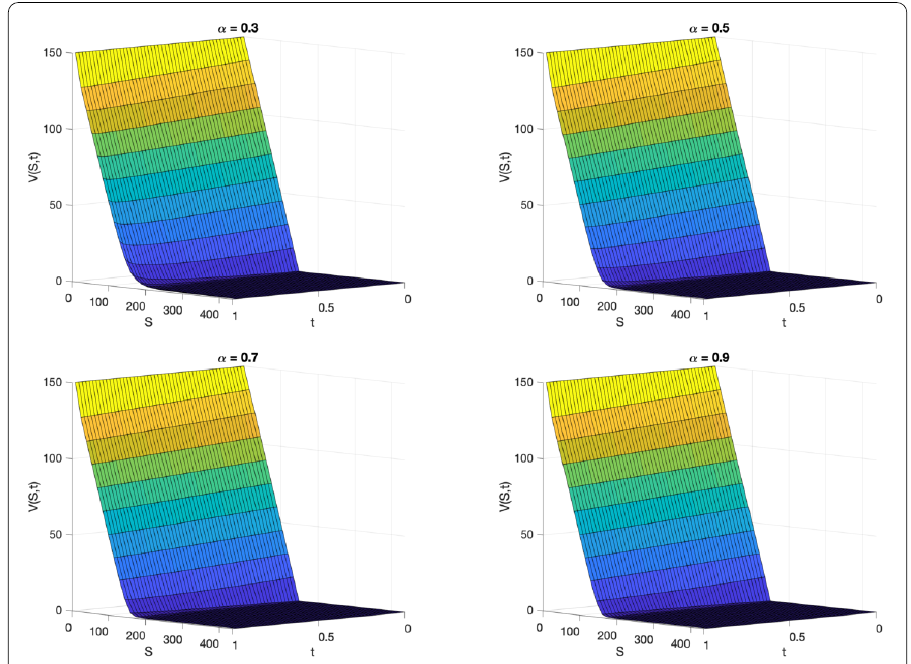
Figure 6 Payoffs under Example 5.1 for α = 0.3,0.5,0.7,0.9; δ = 0.065, for all 0 ≤ t ≤ T